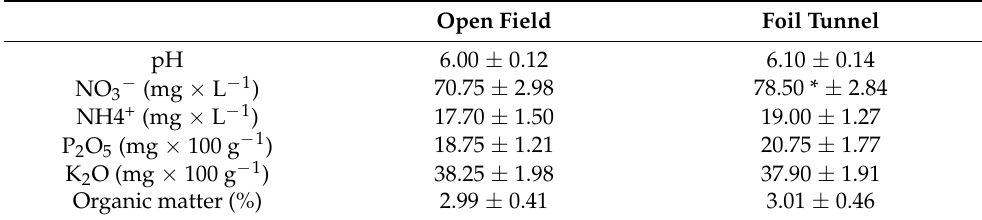
Table 2. Soil parameters (pH, the content of main nutrients and organic